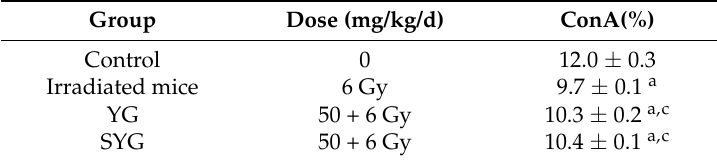
Table 4. Effects of SYG on the splenocyte proliferation ability of mice radiated with 60 Co ( n =